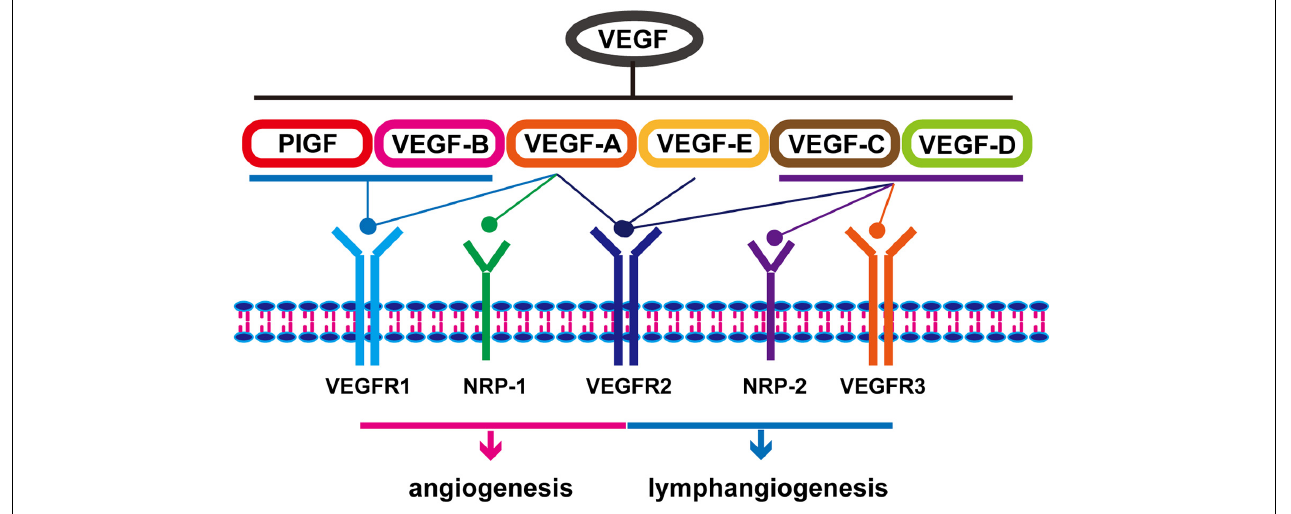
FIGURE 1 | Classification and function of vascular endothelial growth factors.